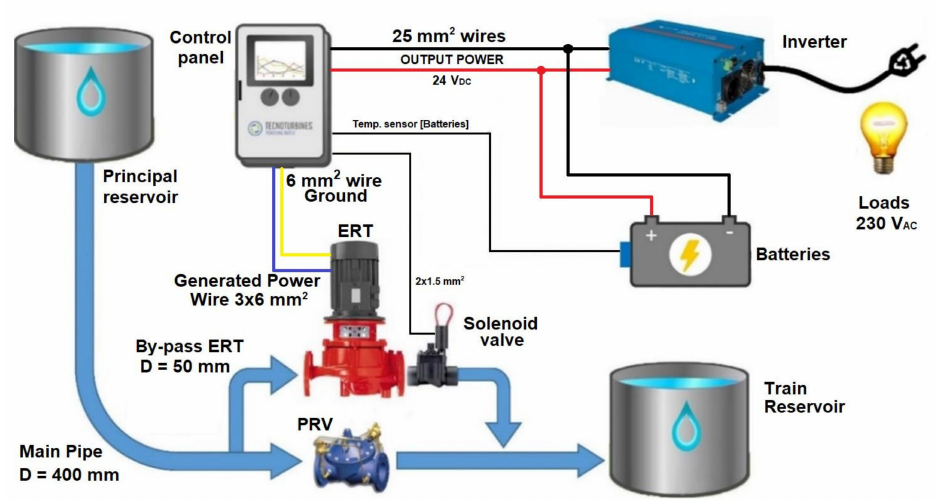
Figure 6. Electro-hydraulic assembly diagram of the ERT in the water network and its